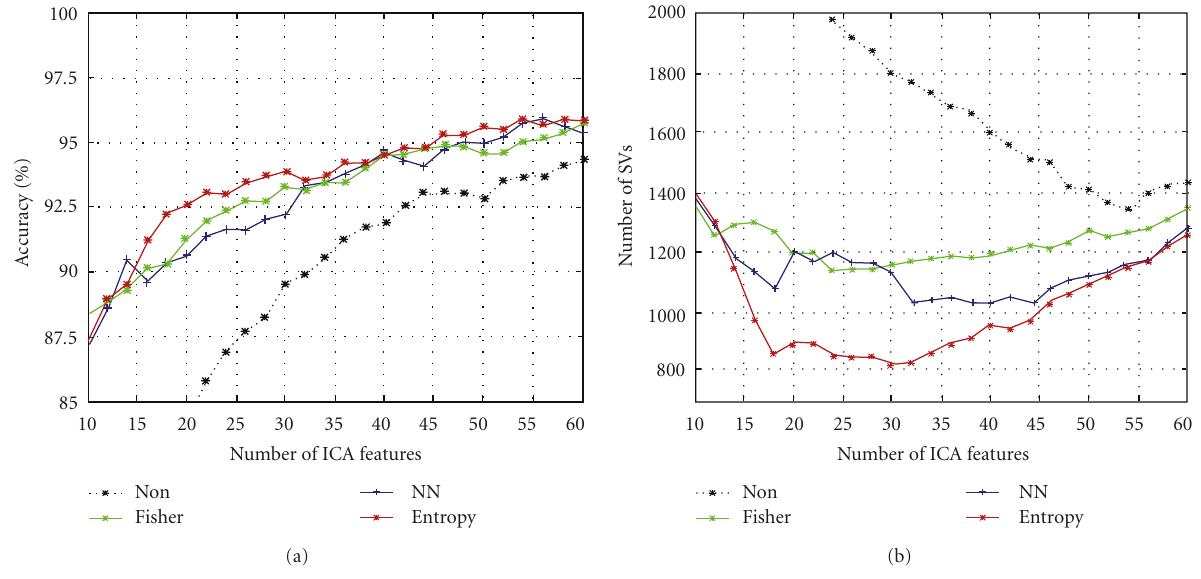
Figure 16: Analysis of di ff erent methods of feature selection in (a) Accuracy rate, and (b) Number of SVs.